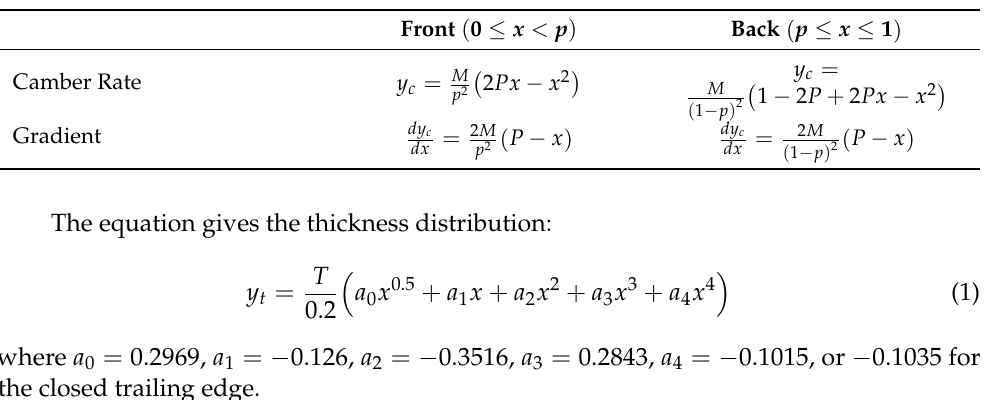
Figure 3. NACA8410 (at the wing tip) to NACA2410 (at the fuselage) wing under stress model. Figure 3. NACA8410-2410 wing under stress model.